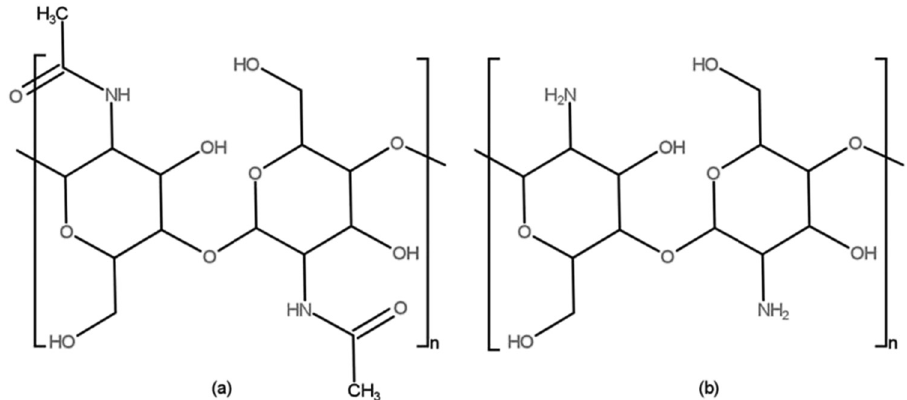
Figure 2: The structure of ( a ) chitin and ( b )